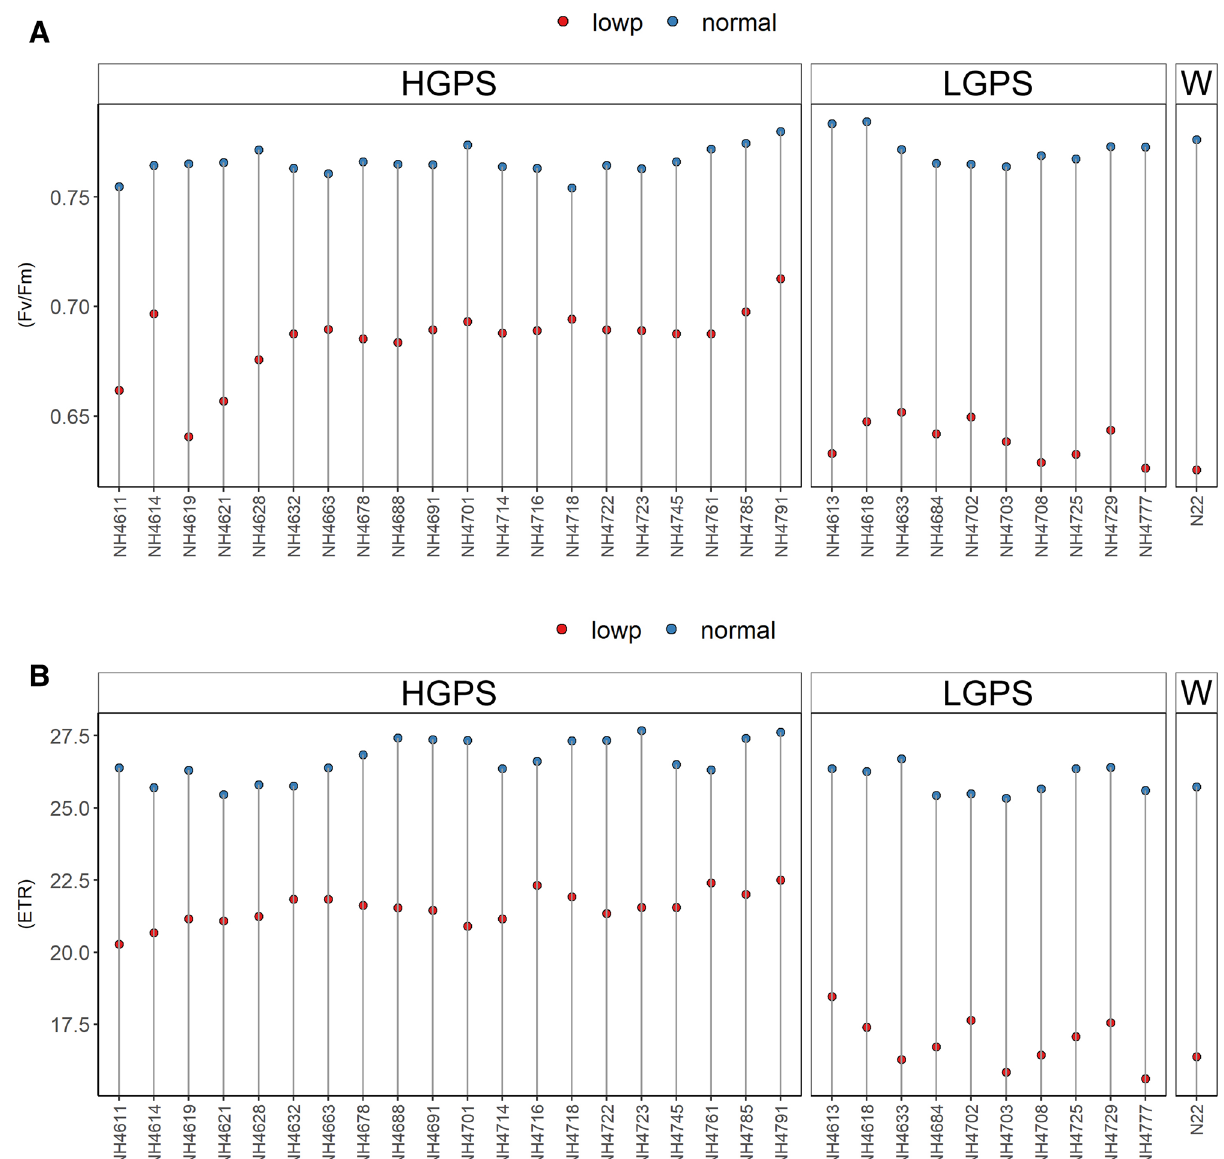
Figure 9. Fv/Fm and ETR of seedlings obtained from germination of seeds harvested from low P (shown as red dots) and normal P (shown as blue dots) fields. Wild type N22 (W), high grain P mutant seedlings (HGPS), and low grain P mutant seedlings (LGPS) were grown under normal P condition. ( A ) Fv/Fm at 24 days of germination. ( B ) ETR at 24 days of germination. The leaf samples at 24th day were collected and kept in dark for 30 min before measuring the Fv/Fm and ETR. The values represent the mean of 6